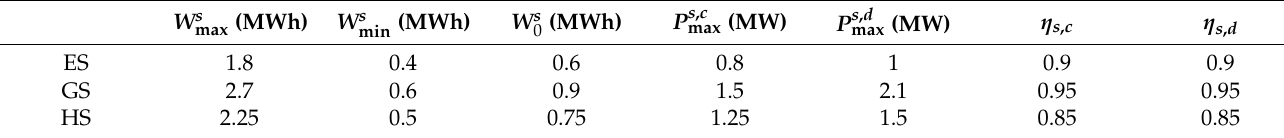
Table 2. Parameters of electricity/gas/heat storage devices.